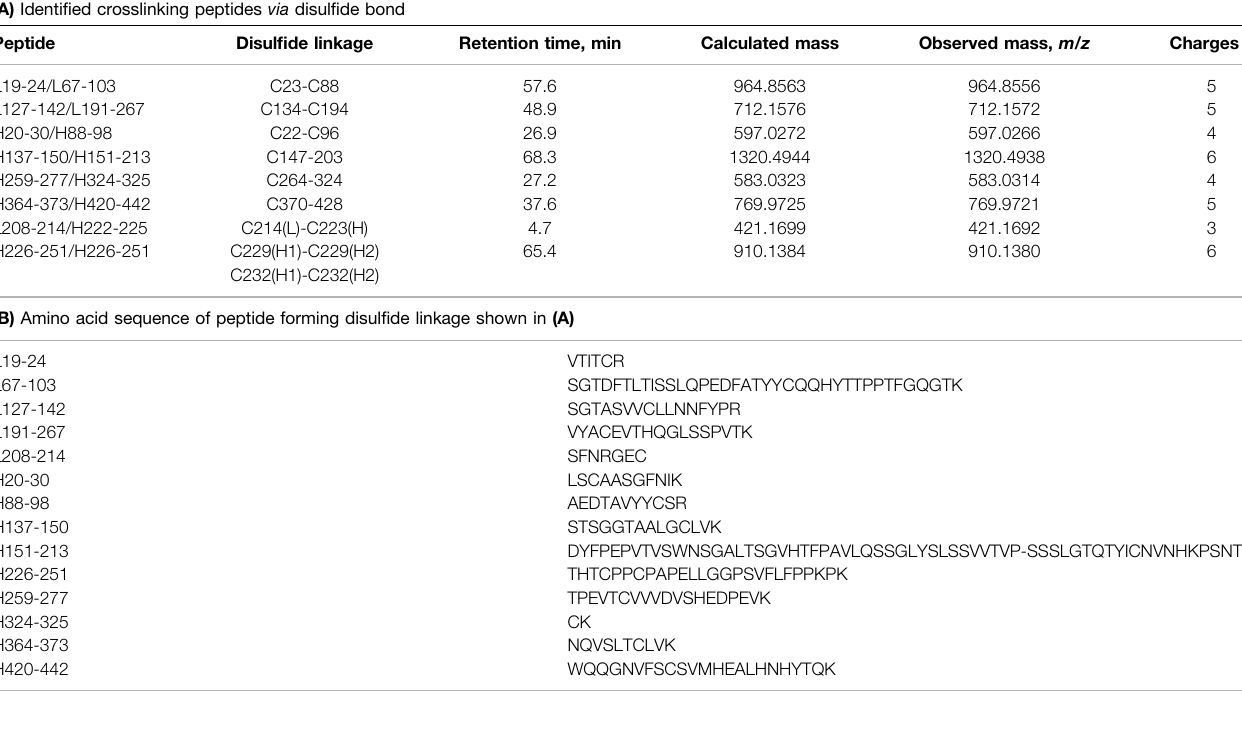
TABLE 2 | Summary of peptide mapping for structural analysis of disul fi de bond formation (A) . Identi fi ed peptides with a disul fi de bond (B) amino acid sequence of peptide shown in (A) . Tryptic digestion was performed under non-reducing conditions. Calculated and observed masses are shown as monoisotopic mass. L and H represent light chain and heavy chain, respectively.